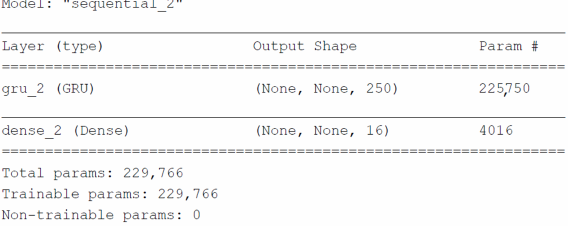
Figure 12. Output shape in the GRU + Dense model.